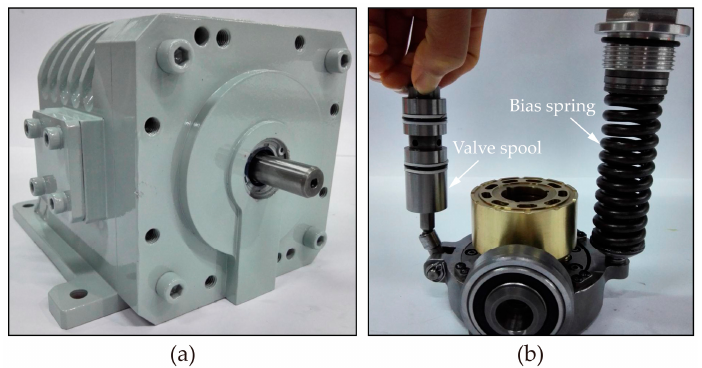
Figure 4. EHA pump prototype with a load sensing mechanism: ( a ) EHA pump prototype; ( b ) Load-sensing mechanism.